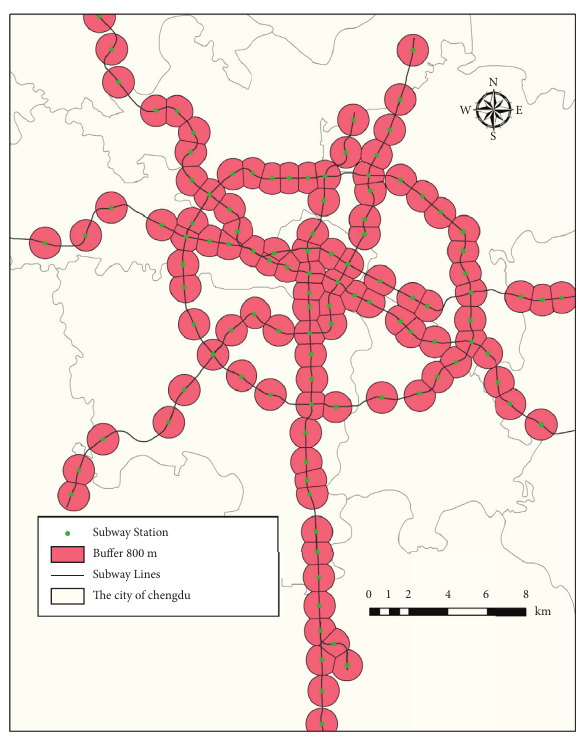
Figure 2: Buffer zone of subway